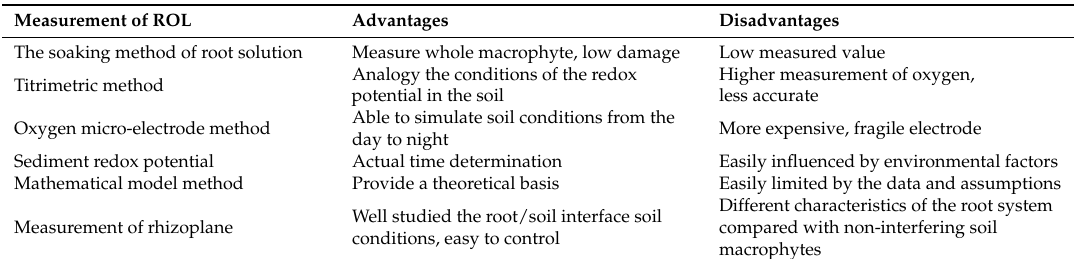
Table 2. The advantages and disadvantages of the methods of measuring